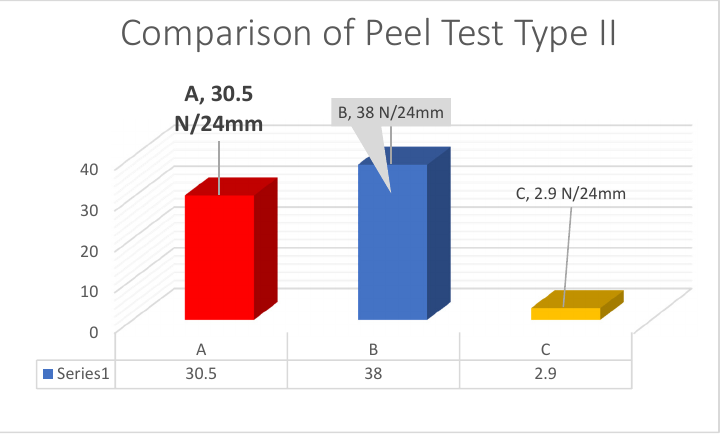
Figure 9. Difference between the peel test results of type II specimens A, B, and C.